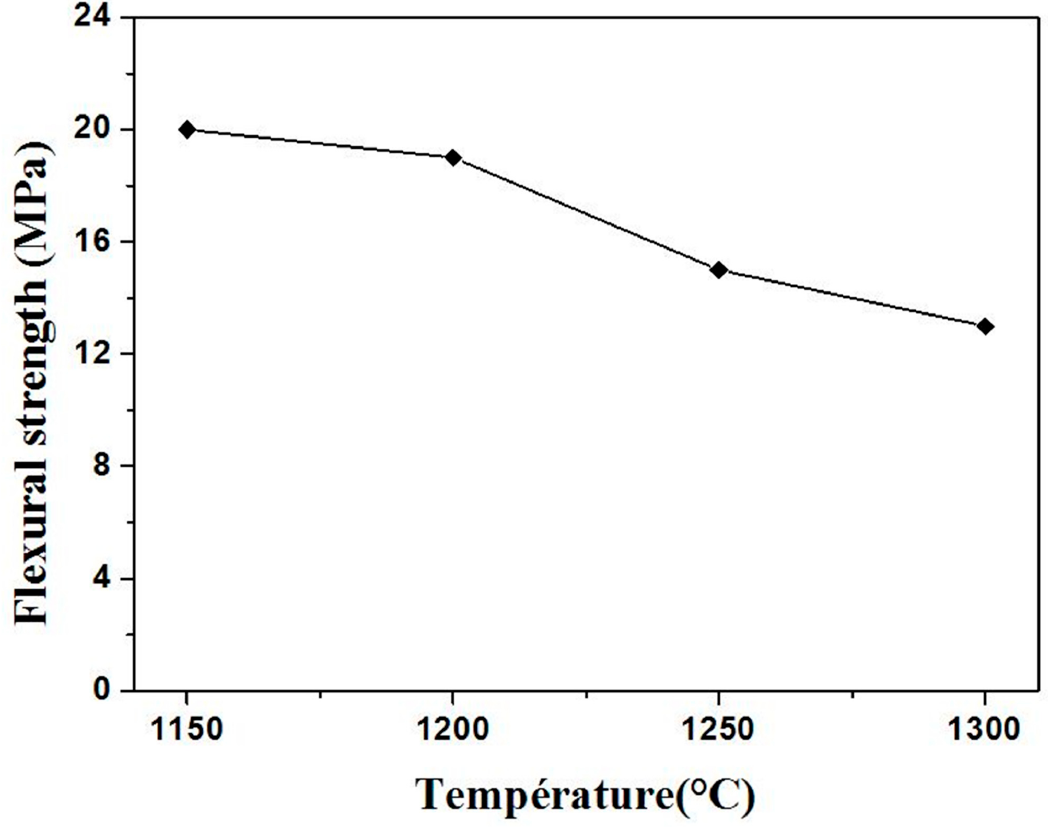
Figure 9. Variation of flexural strength as a function of the sintering temperature. Resistance to corrosion prolongs the lifetime of the supports. In order to assess this property, mass loss measurements were carried out. These were performed after having immersed the first sample into a basic solution of NaOH (pH ≈ 11.90), while for the second sample, an acidic HCl (pH ≈ 2.0) solution was used at a room temperature. Measurements were made as a function of immersion duration up to a maximum of 30 days. Figure 10 shows the results for these specimens, which were sintered at 1250 °C. It is possible to notice that the first support presents a high chemical resistance in basic media since its mass loss was much lower (around 0.1 wt.%) than for those subjected to acidic solution. On the other hand, the mass loss in the second case rose to a value of ≈ 4.9 wt.% after 10 days of immersion and remained stable at this value. Quality wise, this can be considered acceptable. Therefore, it is possible to conclude that the developed supports showed a satisfactory resistance to corrosion regardless of the acidic or basic nature of the medium.